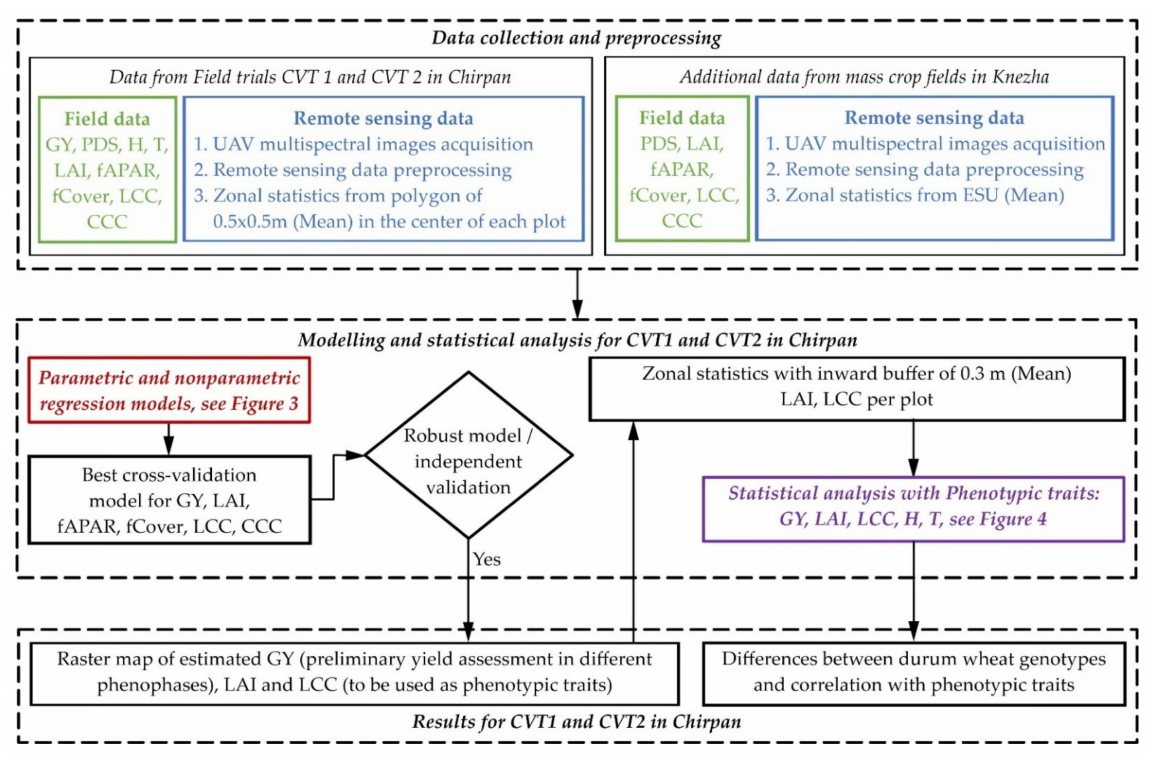
Figure 2. Workflow diagram of phenotypic traits estimation and preliminary yield assessment in different phenophases of a wheat breeding experiment.